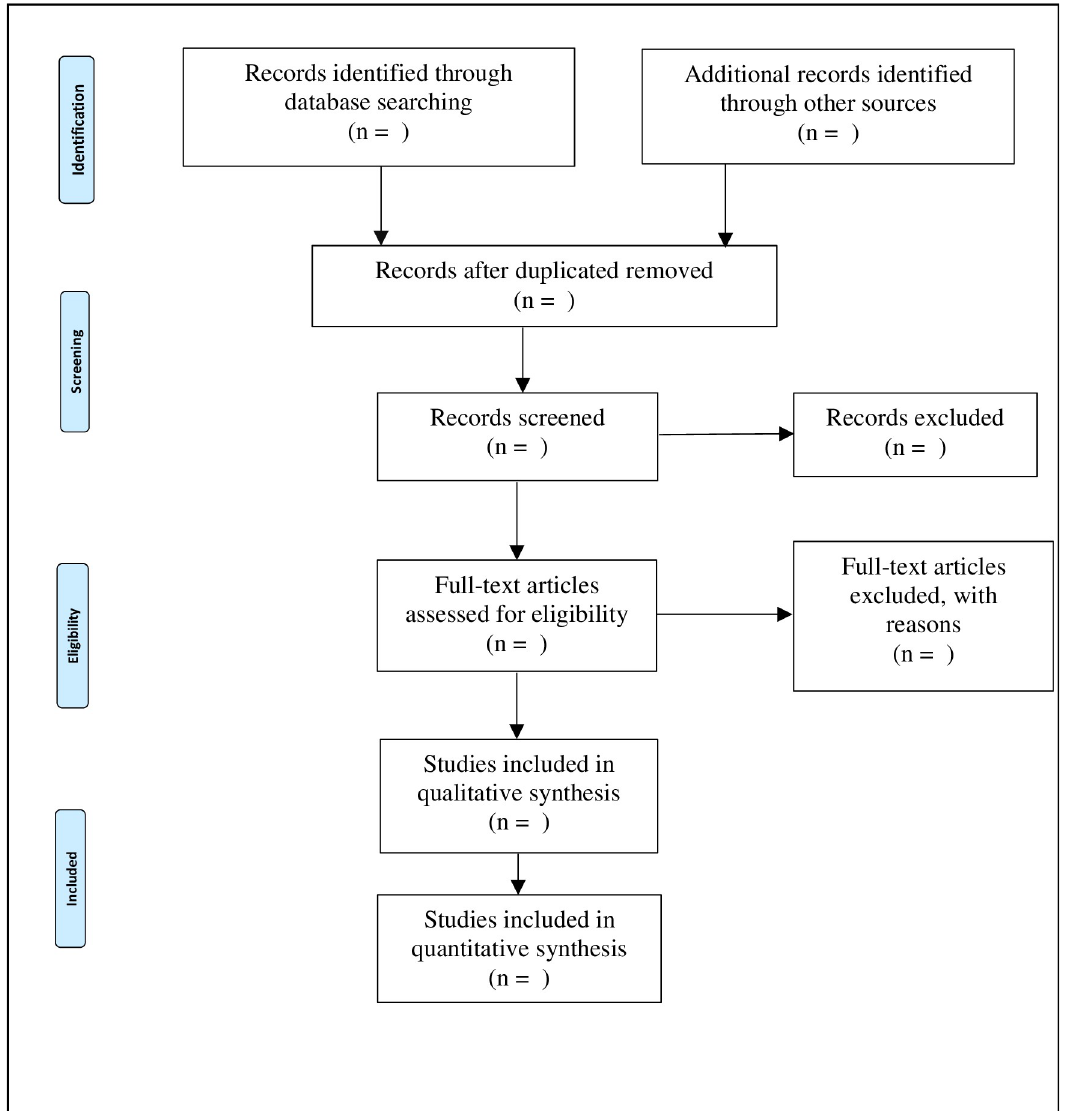
Fig 1. PRISMA flow diagram of the selection of studies to include in a systematic review.